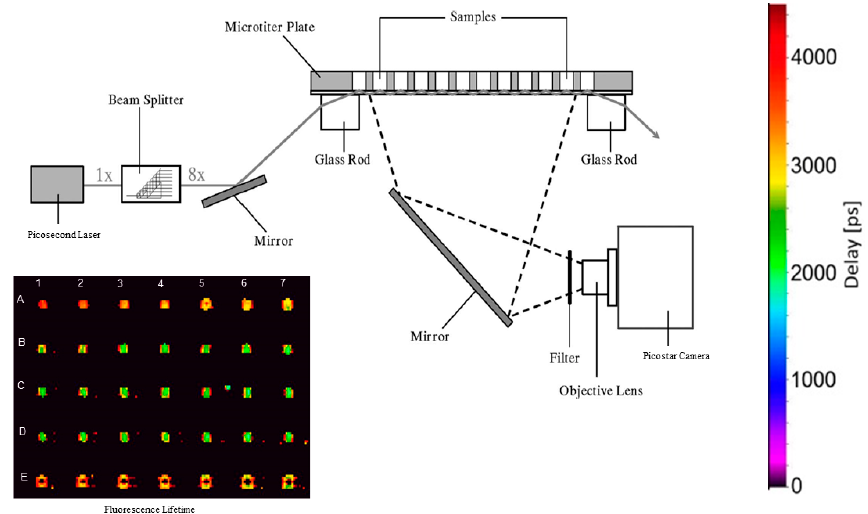
Figure 7. TIR fluorescence lifetime reader for a 96-well microtiter plate including scale. Inset: Fluorescence lifetimes of HeLa hFR-GPI-GFP cells prior to (arrays A,E) and subsequent to (arrays B,C,D) incubation with 30 µ M Nile Red for 10 min.).